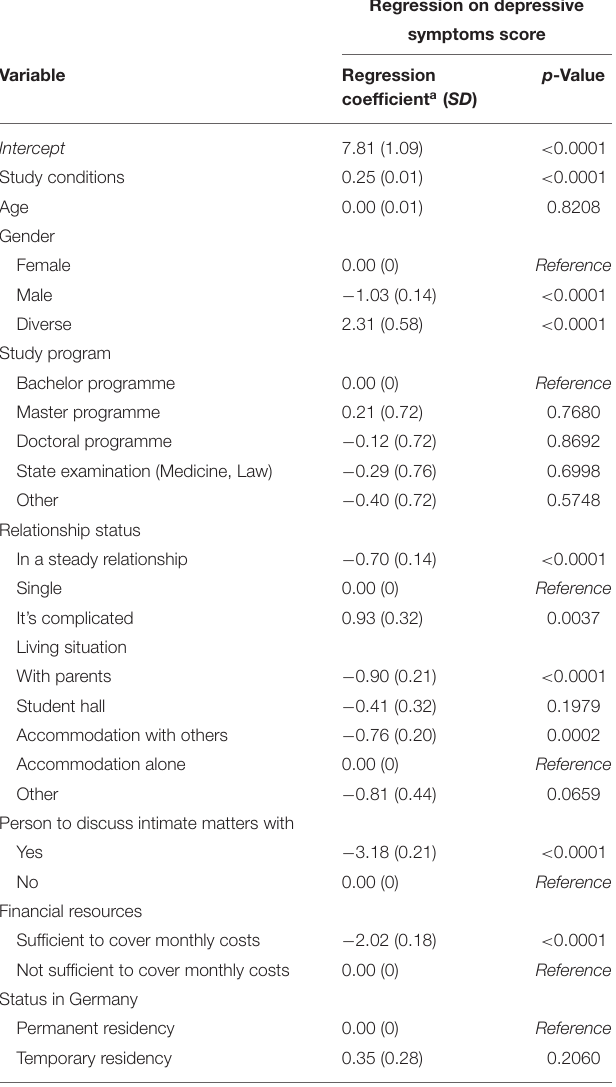
TABLE 5 | Effect estimates of the generalized linear model of study conditions on depressive symptoms.